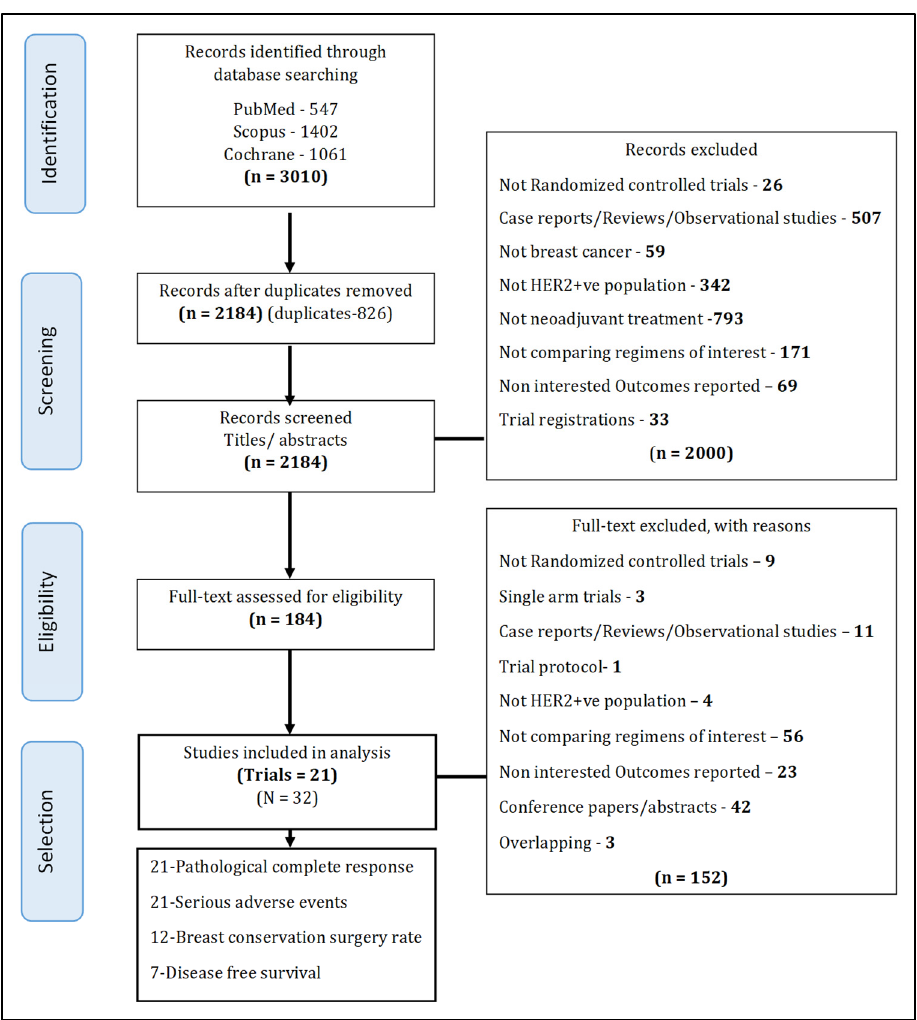
Figure 1. Preferred Reporting Items for Systematic Reviews and Meta-Analyses (PRISMA) flow diagram .